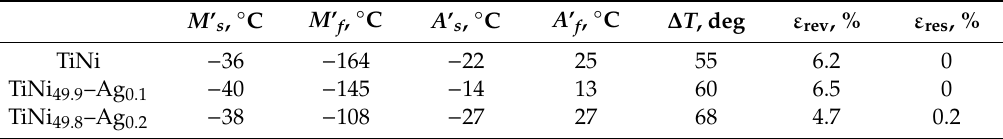
Table 1. Comparative shape memory effect (SME) parameters in TiNi and TiNi–Ag wires. M ’ s ,° С M ’ f ,° С A ’ s ,° С A ’ f ,° С